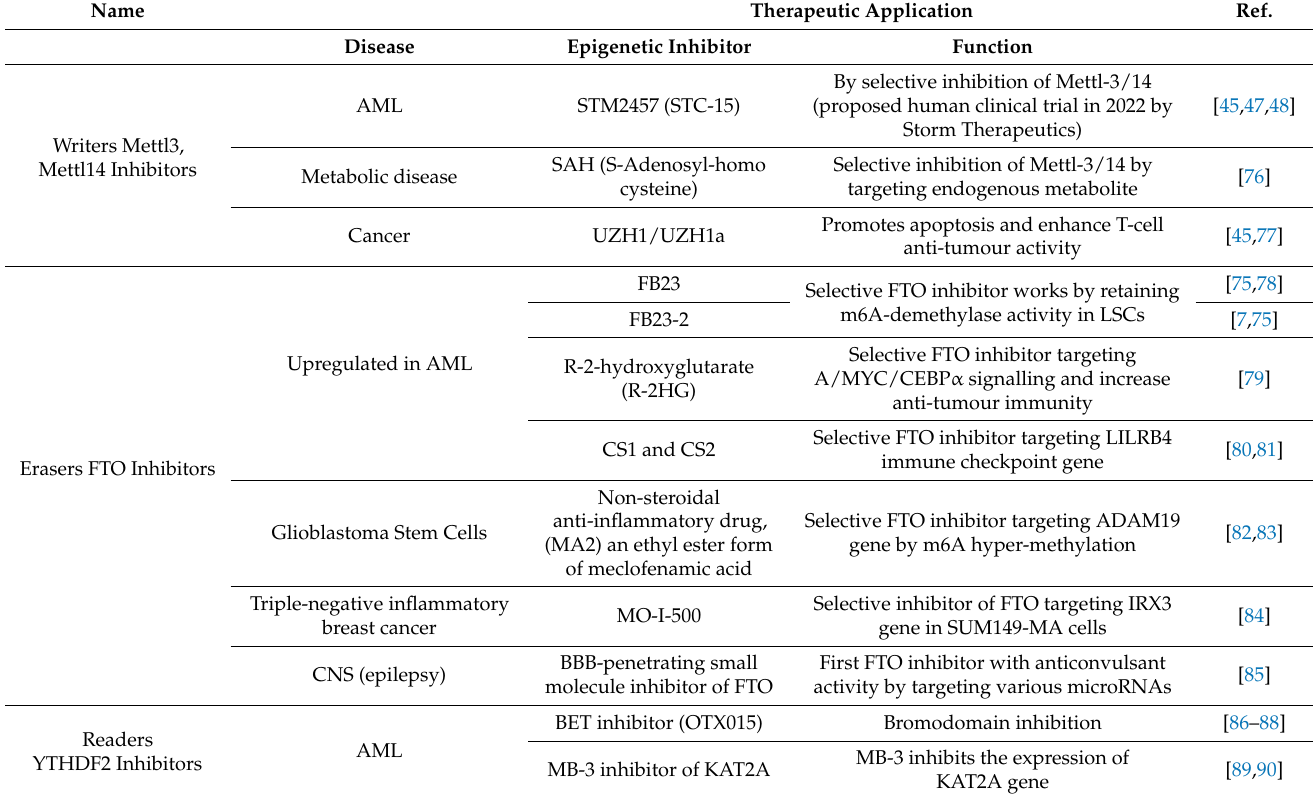
Table 3. Selective inhibitors of m6A-modifiers in AML